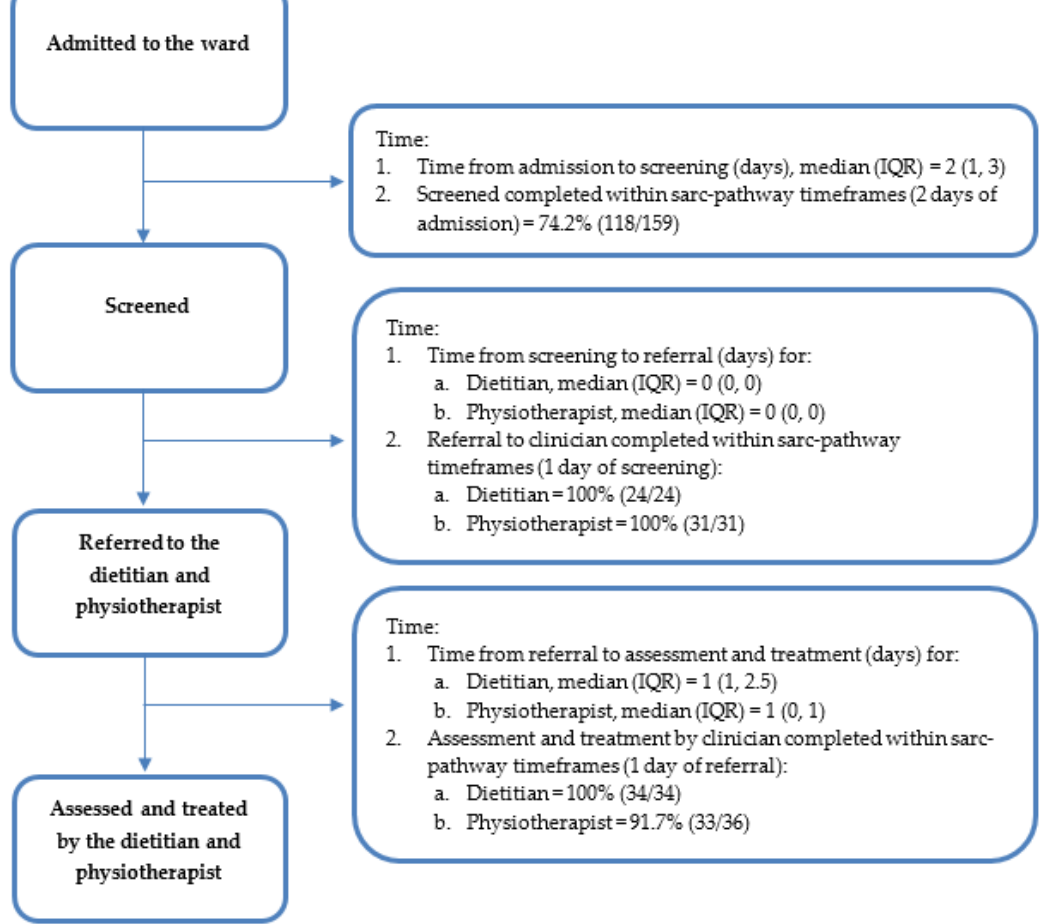
Figure 2. Intervention delivery adherence to key components of the sarc-pathway.